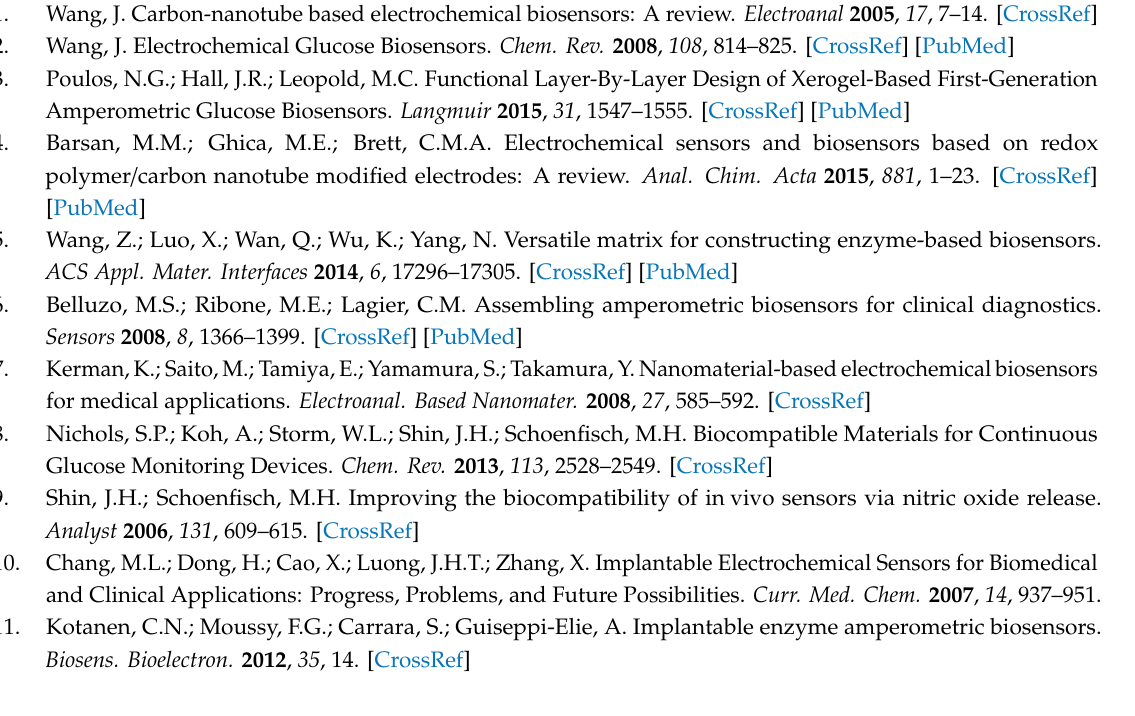
area; Figure SM-3: I-t and calibration curves with and without area standardization (wires); Figure SM-4: I-t and calibration curves for GaOx system at Pt-Ir wire; Figure SM-5: I-t curves for UA and H 2 O 2 injections; Figure SM-6: I-t curve for xanthine injections with and without catalase; Figure SM-7: I-t and calibration curves with interferent testing for XOx system; Table SM-1: Comparison of sensing performance parameters with literature (XOx system); Figure SM-8: I-t and calibration curves for LOx system; Table SM-2: Comparison of sensing performance parameters with literature (LOx system); Figure SM-9: Cyclic voltammetry for Pt-black formation; Figure SM-10: I-t and calibration curves for Pt-black e ff ect (UOx system); Figure SM-11: I-t and calibration curves for GOx system in blood serum and urine (wire); Figure SM-12: I-t and calibration curves for UOx system in blood serum and urine (wire); Figure SM-13: I-t and calibration curves for XOx system in blood serum and urine; Figure SM-14: I-t and calibration curves for GOx system in blood serum and urine